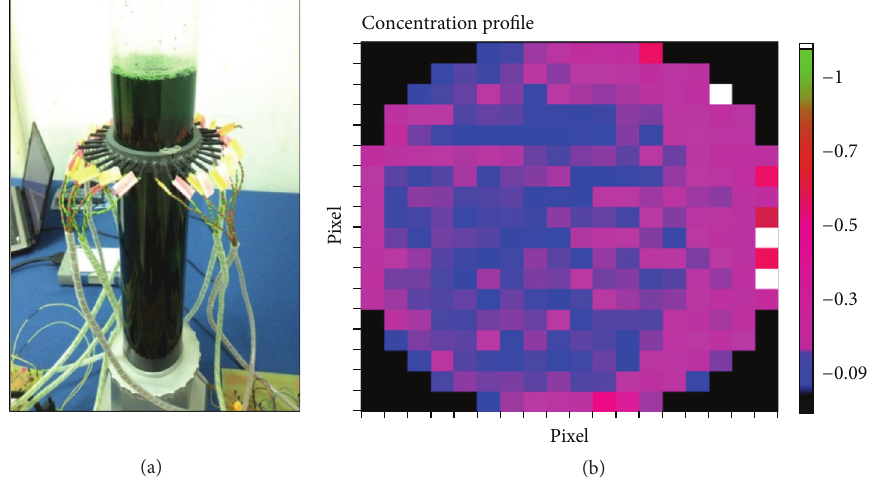
Figure 13: (a) The condition of 100% of air opening. (b) The concentration profile for 100% of air